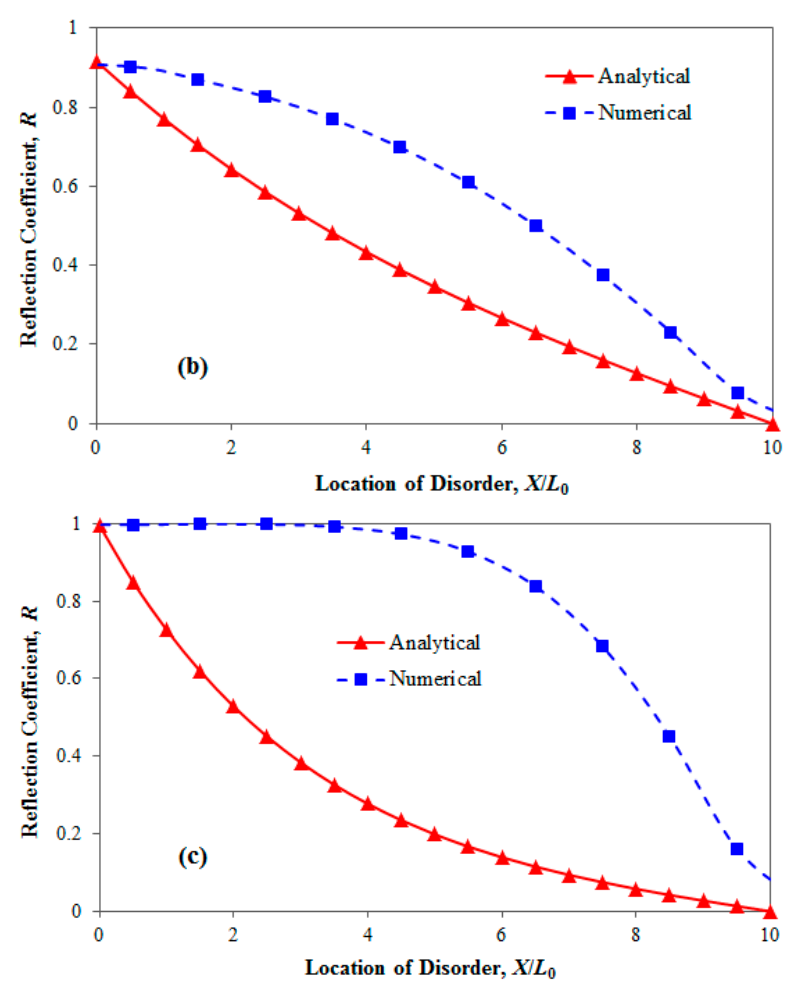
Figure 10. Comparisons of the numerical and analytical results of the reflection coefficients for the case of λ w /2 λ b = 1: ( a ) δ A = 0.05; ( b ) δ A = 0.10; and ( c ) δ A = 0.20.